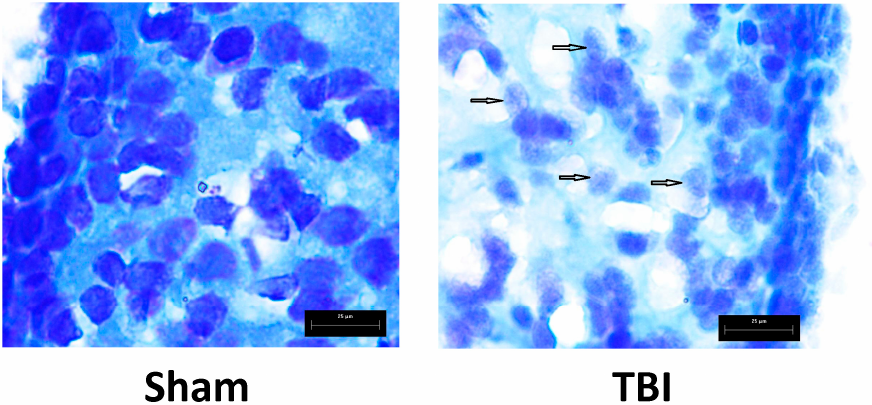
Figure 6. Effects of laser-induced lesion (TBI model) on neuromorphology of the telencephalon one day after the injury in zebrafish. Representative images of Nissl staining; arrows show degenerating neurons. Magnification, ×1000.